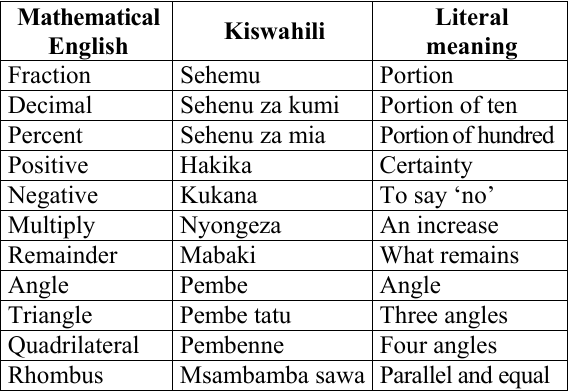
Table 2: Sample of mathematical